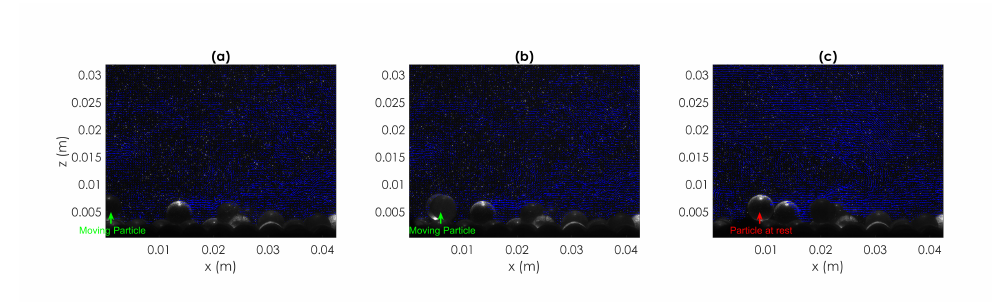
Figure 23. Particle deposited because of the presence of a cluster (particle 3, Test T1). Sequence of three PIV images respectively showing (From ( a – c )): at time t = t 0 (2 time instants, corresponding to 0.1333 s, before disentrainment) the particle is in motion within the field of view; at time t = t 0 + ∆ t (1 time instant, corresponding to 0.067 s, before disentrainment) the particle is approaching its rest location; at time t = t 0 + 2 ∆ t the particle is at rest in the bed.(For clarity only 1 out of 2 vectors are depicted.)